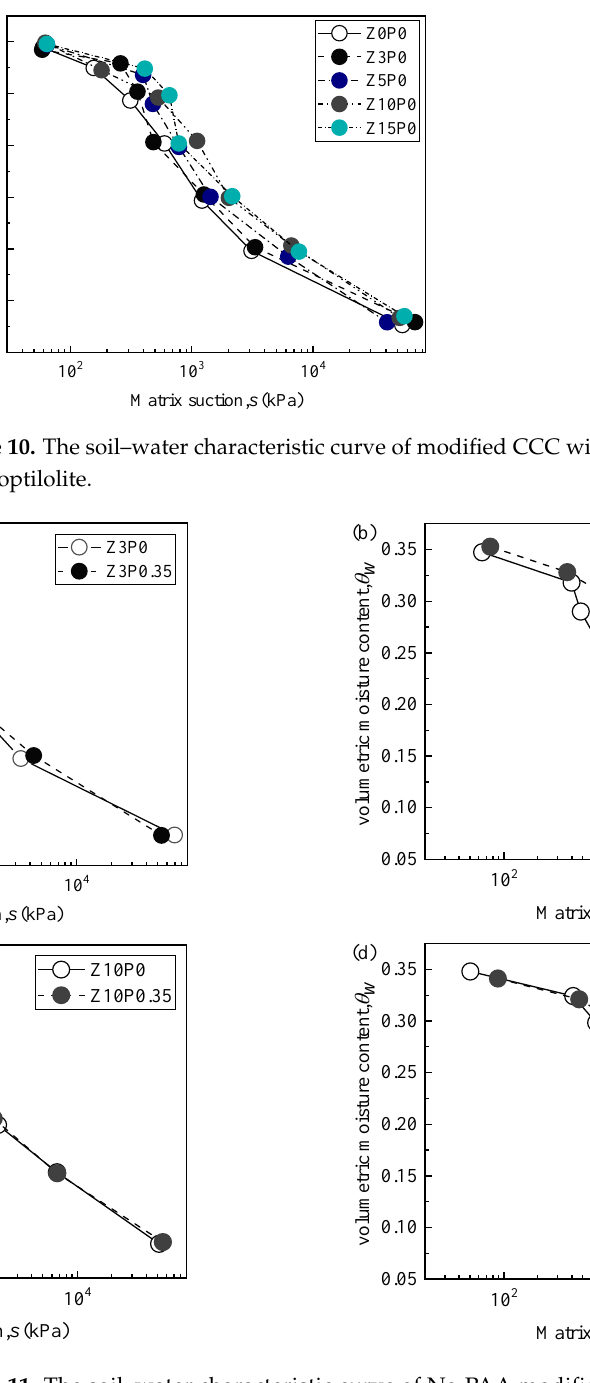
Figure 11. The soil – water characteristic curve of Na-PAA modified mixed soil. ( a ) SWCC of Z3P0 and Z3P0.35; ( b ) SWCC of Z5P0 and Z5P0.35; ( c ) SWCC of Z10P0 and Z10P0.35; ( d ) SWCC of Z15P0 and Z15P0.35. From Figure 10, when the level of matrix suction of Z3P0 is about 50–400 kPa, the SWCC shifts to the upper right compared with Z0P0, but when the matrix suction level is more than 400 kPa, it tends to be consistent with Z0P0. When the matrix suction of Z5P0 is about 50–10,000 kPa, the SWCC shifts to the upper right compared with Z0P0, and when the matrix suction is more than 10,000 kPa, the SWCC tends to be consistent with